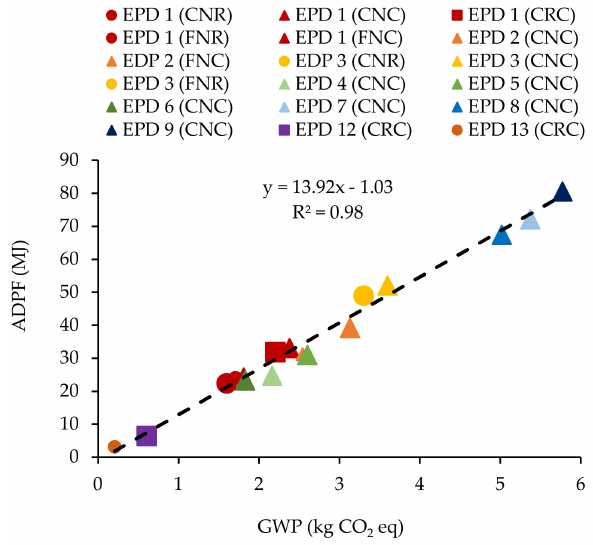
Figure 5. GWP (kg CO 2 eq) vs. ADPF (MJ) results from the EPD, per tonne of